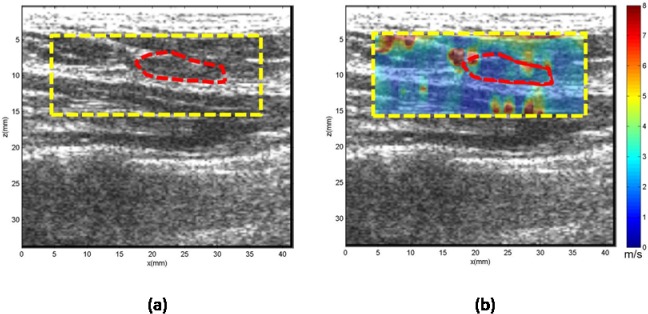
US and CUSE shear wave speed map of breast tissue (dashed yellow contour) including the breast mass ROI (red dashed contour).(a) B-mode US image. (b) CUSE shear wave speed map.